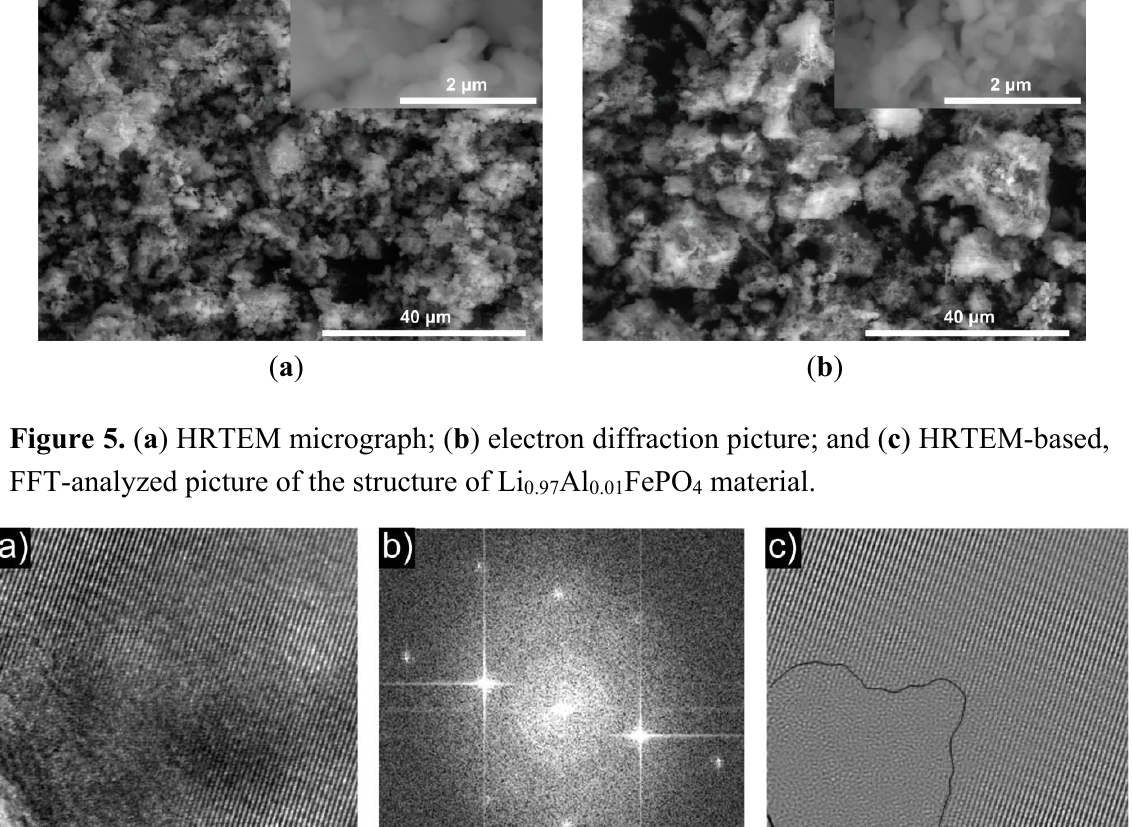
Al FePO powders. 0.97 0.01 4